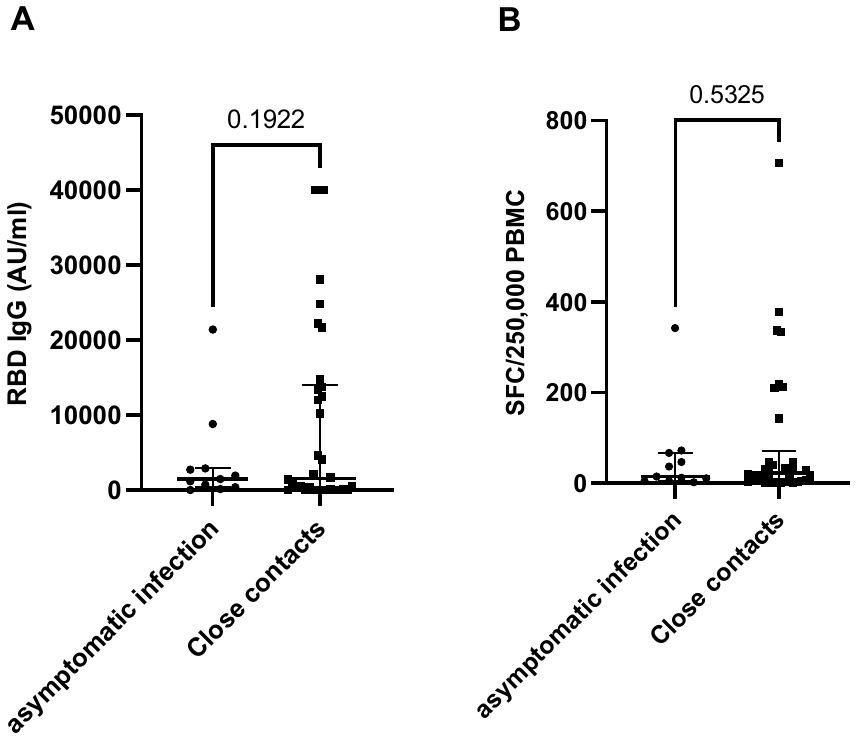
Figure 3. Immune response against SARS-CoV-2 viral antigens between close contacts with and without asymptomatic infection, antibody response (RBD IgG) P = 0.1922 t = 1.325, df = 43 ( A ), T-cell response against the spike protein P = 0.5325, t = 0.6293, df = 43 ( B ). RBD IgG SARS-CoV-2 receptor-binding domain immunoglobulin G, AU/ml = arbitrary units per